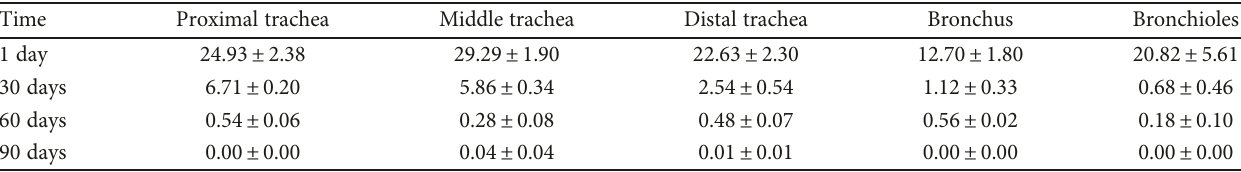
Figure 4: Immunohistochemistry staining of BrdU-labeled epithelial cells in porcine tracheal epithelium. Representative images of IHC staining of colocalization of BrdU and epithelial cell type marker keratin 14 and mucin 5AC in the trachea of porcine at day 1 post BruU pulse. (a, b) Colocalization of keratin 14 (brown) and BrdU (red) in the proximal (a) and middle (b) trachea of a pig lung determined by IHC. (c, d) Colocalization of mucin 5AC (brown) and BrdU (red) in the proximal (a) and middle (b) segments of the trachea in a pig lung determined by IHC and counterstained with hematoxylin (blue). Bar =50 μ m. Table 2: Mean percentage of lineage-labeled keratin 14-positive cells ± SEM in di ff erent regions of porcine conducting airway over a time period of 90 days